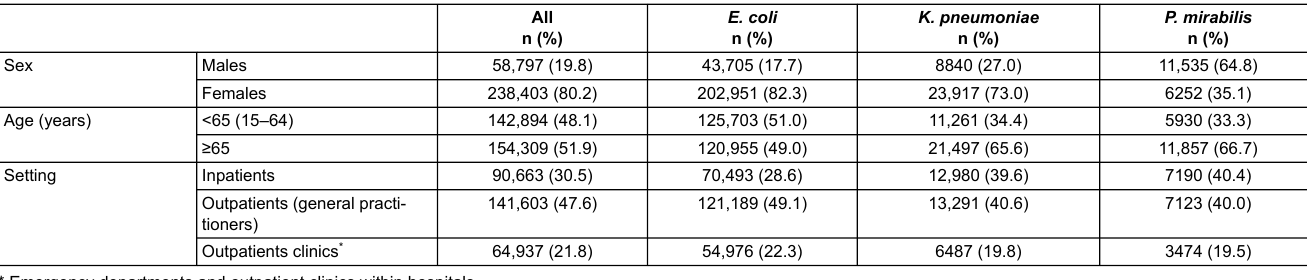
Table 2: Characteristics of the study population.